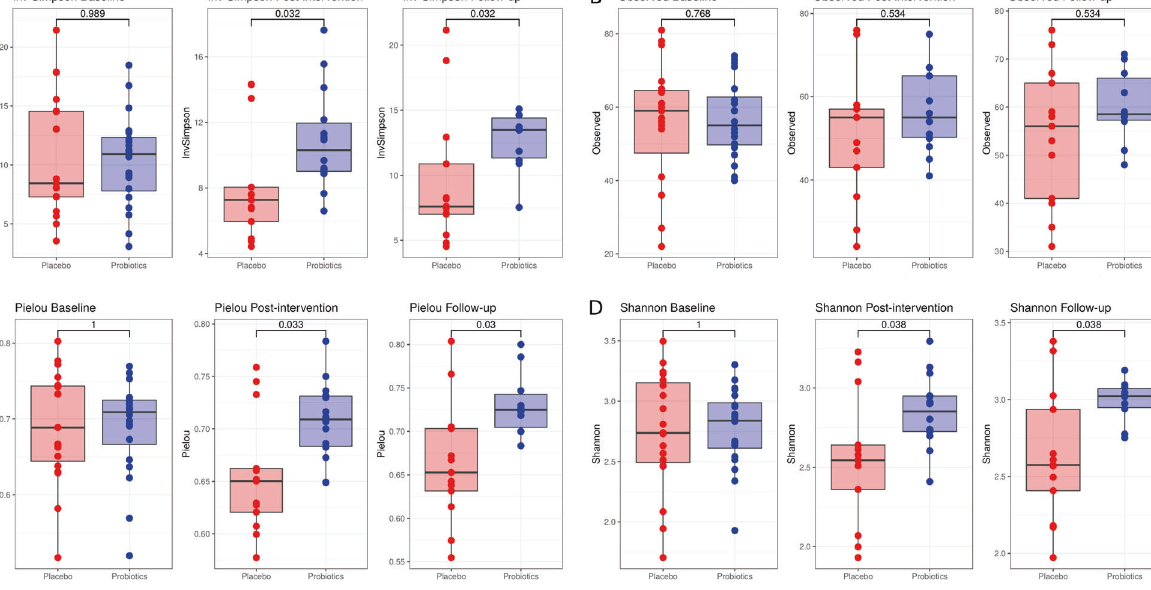
Fig. 3 Alpha-diversity comparisons between study groups at all three time points. A Inversed Simpson index, B observed richness, C Pielou ’ s evenness, and D Shannon